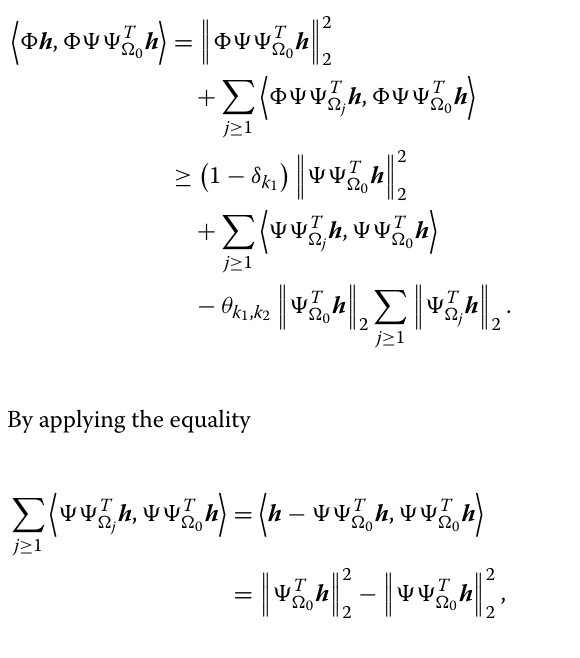
A direct result is that if the condition 0 ≤ k 1 holds, one can easily get (8) for all 0 < q ≤